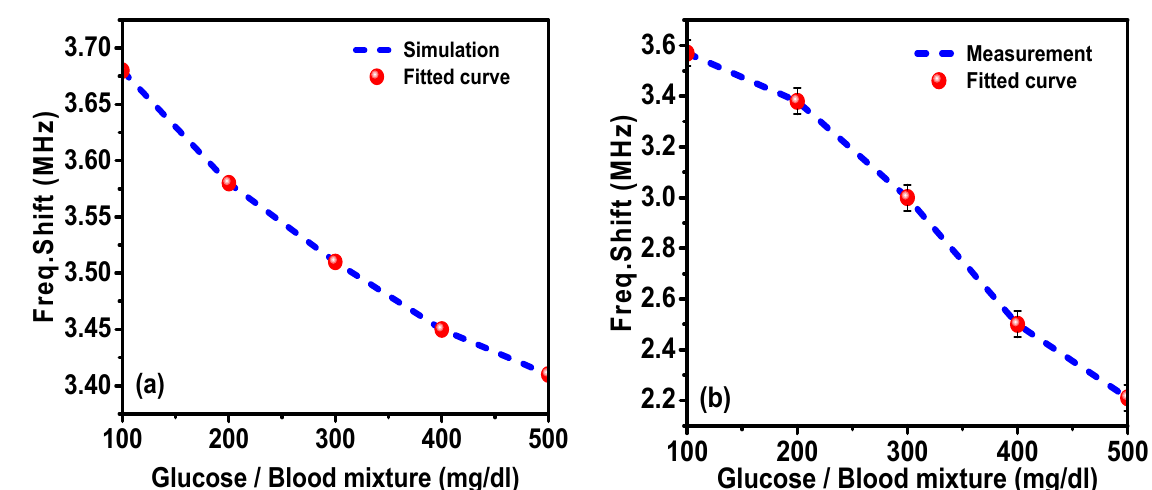
Figure 14. A comparison of resonance frequency shift versus the glucose concentration in blood: ( a ) simulation and ( b ) measurement.